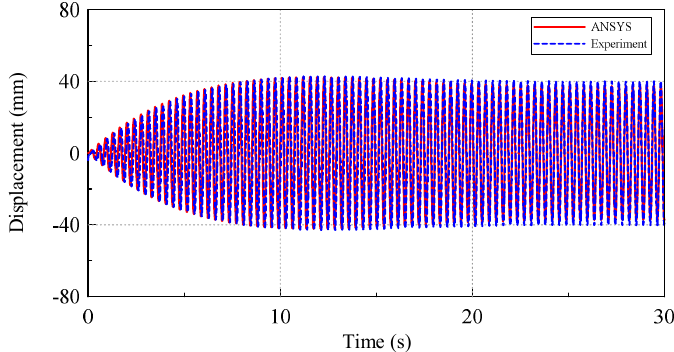
Figure 8. The history of the displacement at the rotor nacelle assembly (RNA) of OWT under excitation wih exciting frequency = natural frequency of the OWT.